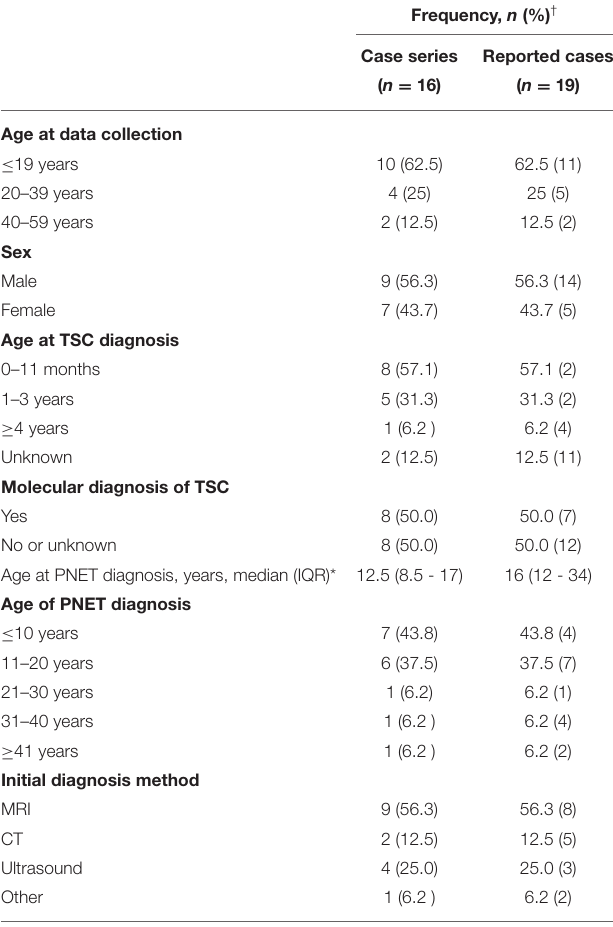
TABLE 3 | Demographic information of patients in this case series and published case